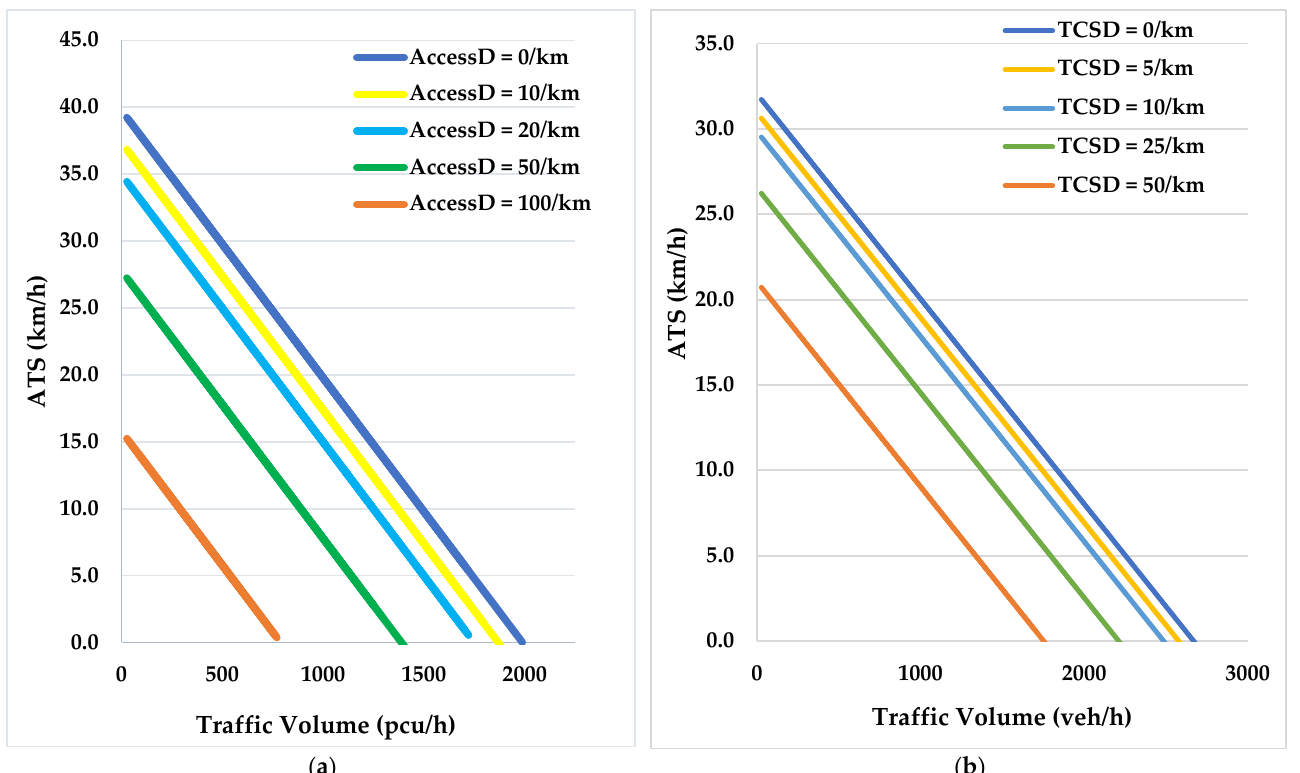
Figure 9. ( a , b ) Speed-flow models for road’s categories [M0, NL1, SF0] and [M0, NL2, SF1].